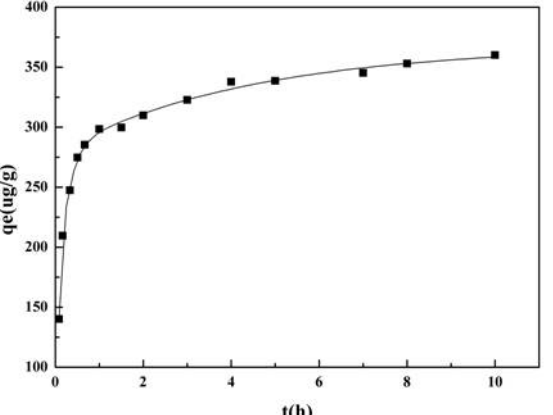
Figure 5. Adsorption kinetic curve of 1-DNJ in mulberry leaves with 732